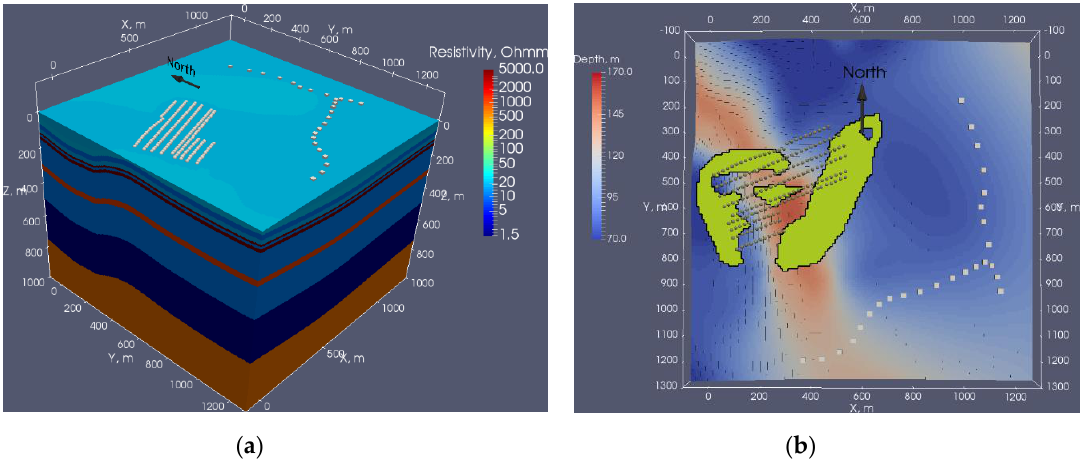
Figure 10. ( a ) The 3D resistivity model used in the numerical experiment (the shallowest 6 m were removed for visualization). The receivers are depicted as spheres, the two transmitters lines are marked by boxes. Resistivity is shown in color. ( b ) Structure of the shallow geology. The topography of the top of the limestones is shown in color (blue to red). The sand body buried at a depth of 20 m is shown in solid green. The model is attached to the electronic version of this article.